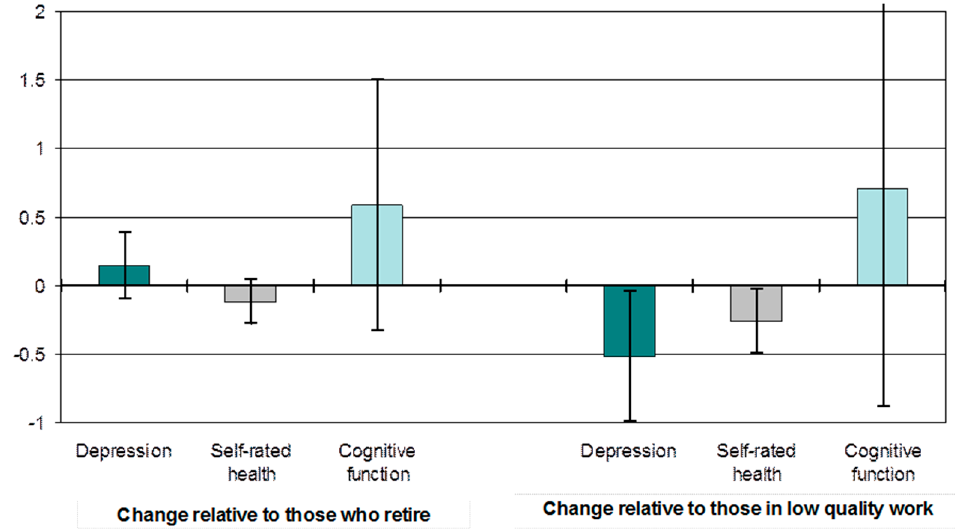
Figure 4. Impact of retirement on change in health: all who stay in work post state pension age compared with those who retire; and those who stay working in high quality work compared with those who stay working in low quality work.